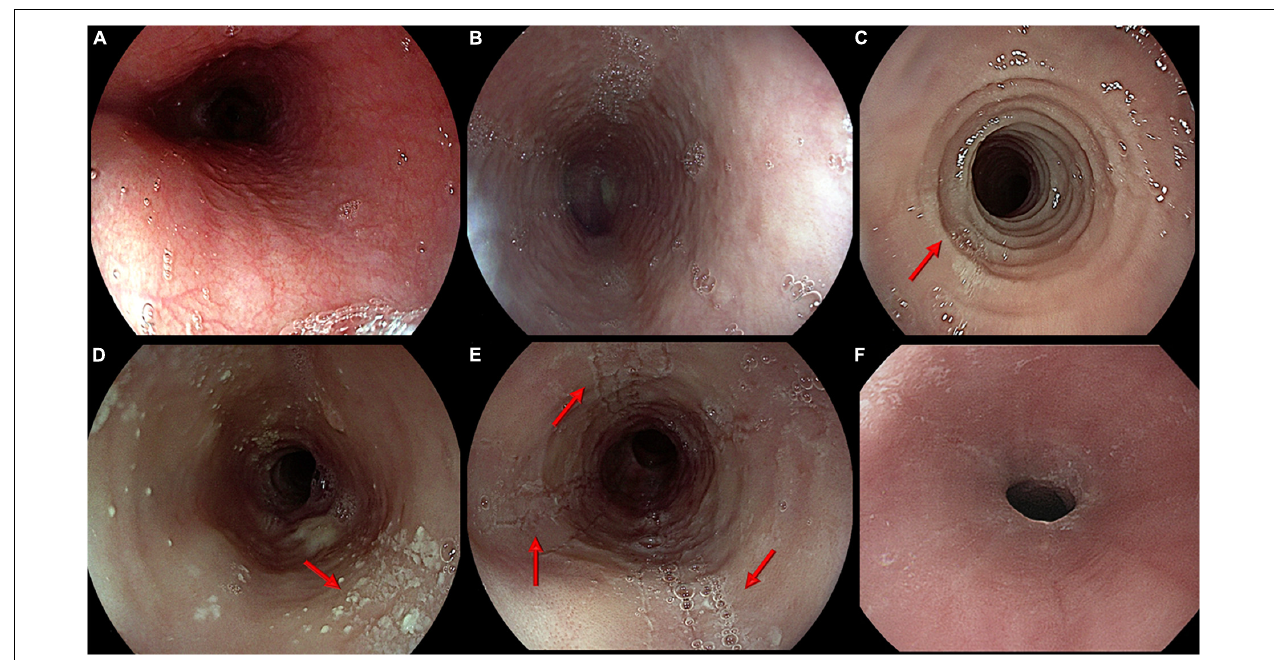
FIGURE 1 | Main endoscopic features of eosinophilic esophagitis. From top left: (A) Normal appearance of esophageal mucosa; (B) Edema. Pale mucosa with attenuation of the normal vascular pattern; (C) Rings. Trachealized esophagus with multiple concentric rings (arrow); (D) Exudates. Whitish small plaques not washable through water jet (arrow); (E) Furrows. Typical longitudinal furrows (arrows); (F) Stricture. Narrowing of esophageal lumen not passable by a standard scope (diameter around 9